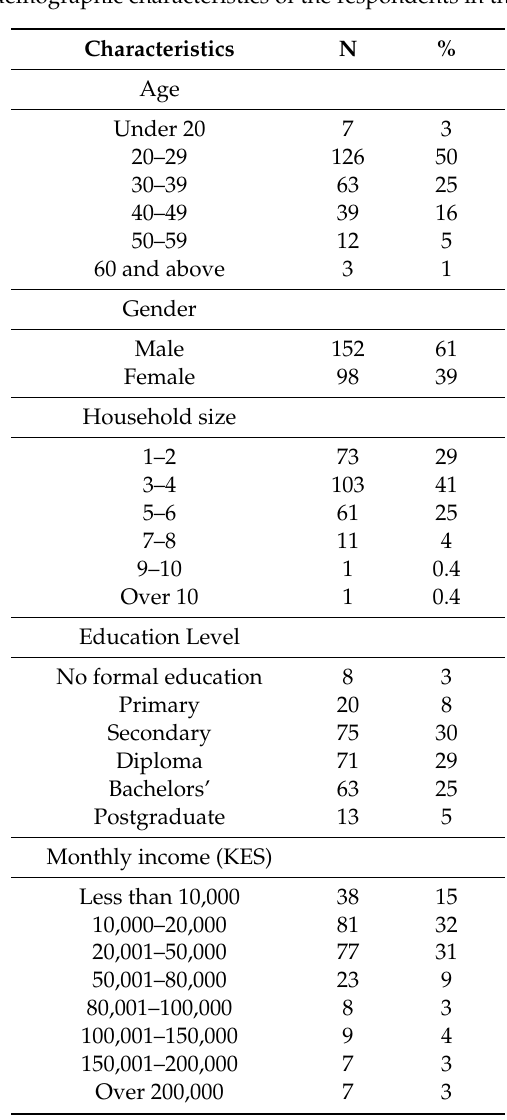
Table 1. Socio-demographic characteristics of the respondents in the three